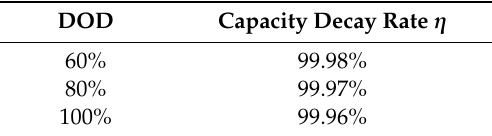
Table 4. Capacity decay rates under di ff erent depth of discharge